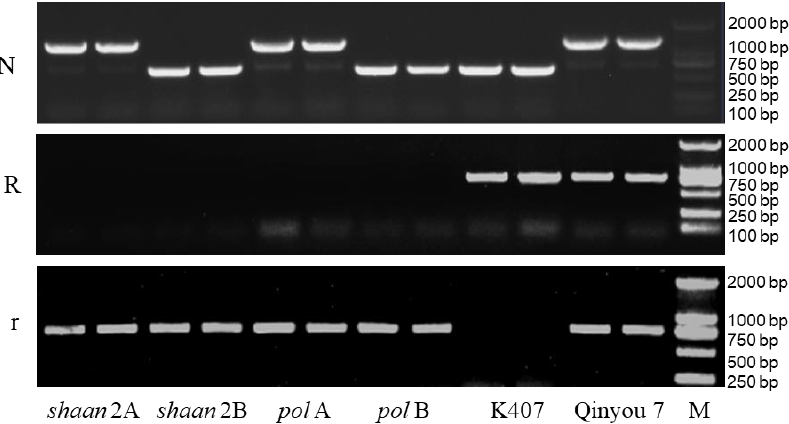
Figure 3. Identification of pol A and shaan 2A and their maintainers by the molecular markers. N, fertile cytoplasm gene N; S, sterile cytoplasm gene S; R, fertility nuclear restorer gene; r, recessive nuclear sterile gene; M, DNA marker.